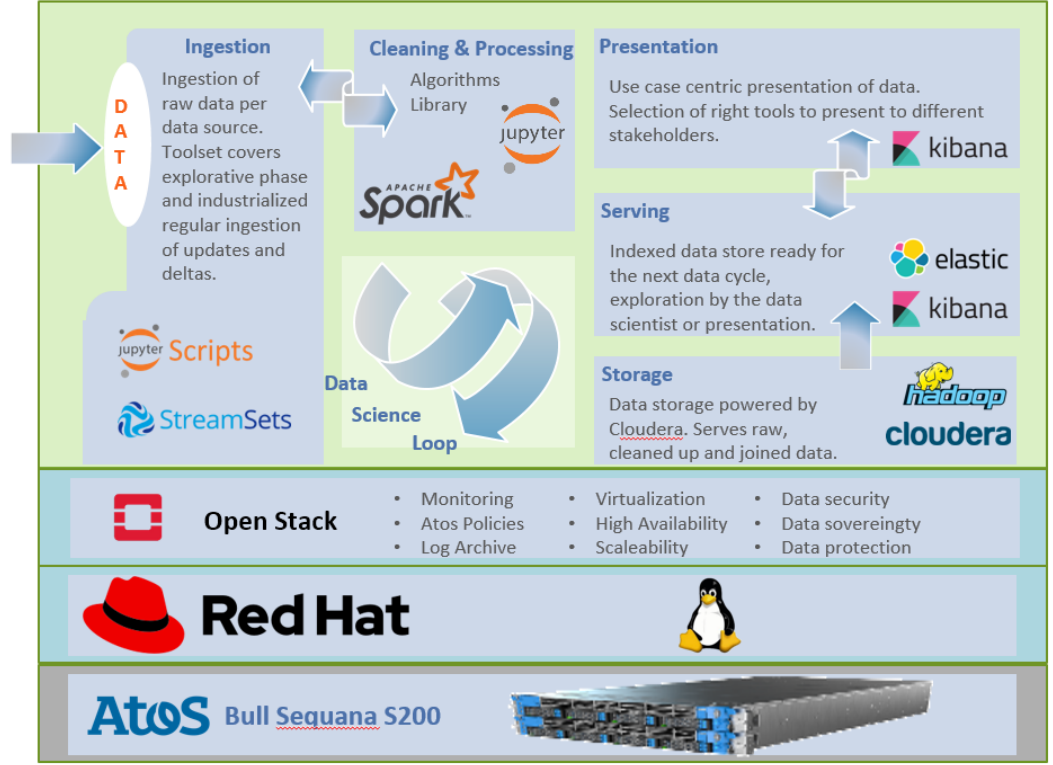
Figure 17. Data analytics software stack and the data science loop.